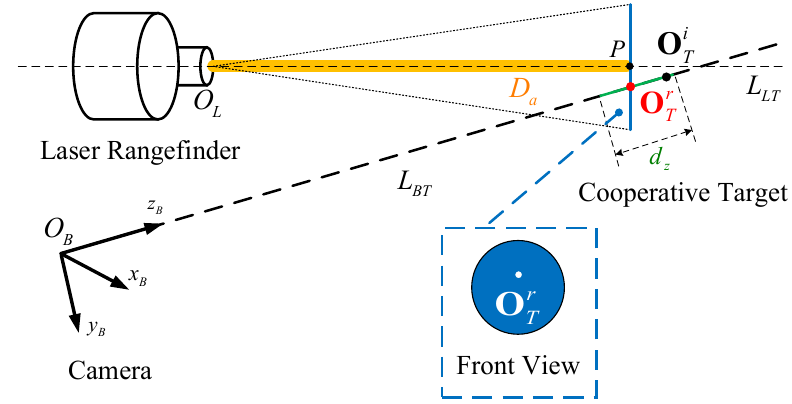
Figure 4. Diagram of the proposed fusion algorithm.